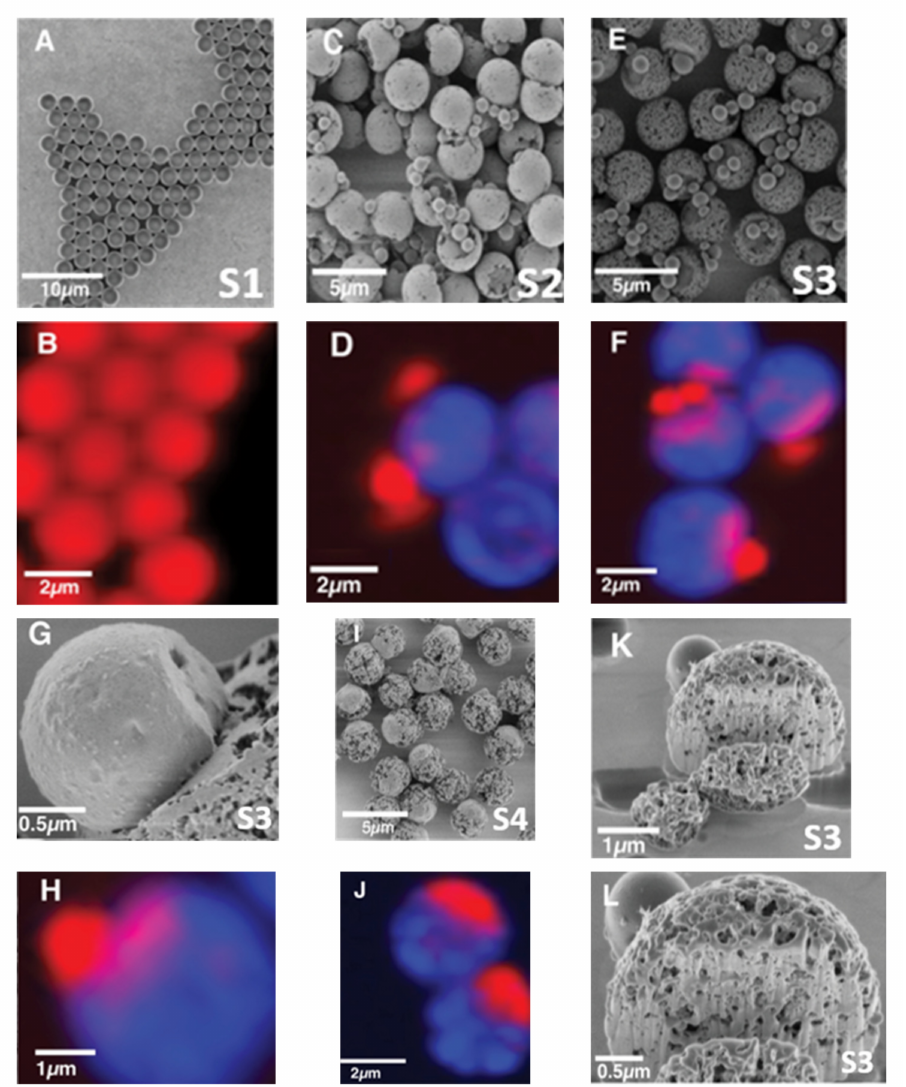
Figure 2. Particles S1 – S4 imaged by SEM ( A , C , E , G , I ) and the corresponding Raman images ( B , D , F , H , J ). A magnified SEM image of S3 ( G ) and the corresponding Raman image ( H ) are shown. A particle of the sample S3 milled with Ga + FIB ( K , L ). Particles S1 ( A , B ) consist of pure polystyrene. Particles S2 , S3 , and S4 consist of poly (glycidyl methacrylate-co-ethylene di-methacrylate) polymer with an increasing concentration of porogen S2 ( C , D ; 7 mL porogen), S3 ( E , F ; 14 mL porogen), and S 4 ( I , J ; 21 mL